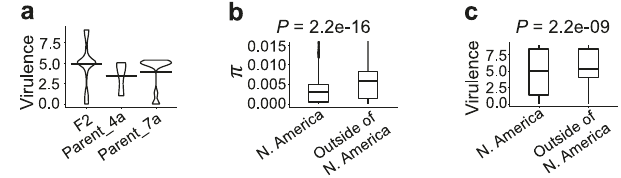
Fig. 8 | Relationship between Pgt virulence, admixture, and sexual recombi- nation. a Violin plot showed increased virulence of the F 2 Pgt progeny on disease resistance genes Sr7b , Sr11 , Sr6 , Sr9b , Sr30 , and Sr24 compared to two parental isolates (4a or CDL 78-21-BB463, race BFBJC; 7a or CDL 75-36-700-3, race SCCLC). b Genetic diversity ( π ) was lower in the sample of North American Pgt isolates ( n =15)thaninthesampleofisolatesoutsideofNorthAmerica( n =22).(Two-sided Mann – Whitney U -test p value=2.2e-16). Outliers of π greater than 0.015 are not displayed. c Virulence was reduced in the isolates from North America ( n =15) comparedtotheremainingpopulation( n =22)(Two-sidedMann – Whitney U -test p value=2.15e-09). Box plots show the median and interquartile ranges (IQR). The end of the top line is the maximum or the third quartile (Q)+1.5×IQR. The end of the bottom line denotes either the minimum or the fi rst Q − 1.5×IQR. The dots are either more than the third Q+1.5×IQR or less than the fi rst Q −